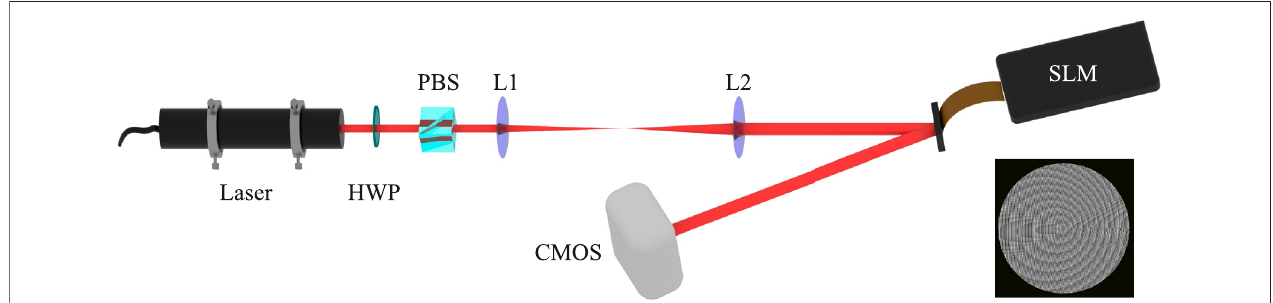
FIGURE 2 | Schematic of the experimental setup. The inset is the phase hologram of the spiral axicon loaded on the SLM. HWP, half-wave plate; PBS, polarized beam splitter;L, Lens; SLM,spatiallightmodulator.HWP,PBS,L1,and L2areused tocontrol theintensityand radius ofthebeam. TheSLMimplementsaspiralaxicon to produce the AVB. The CMOS detects the generated AVB.